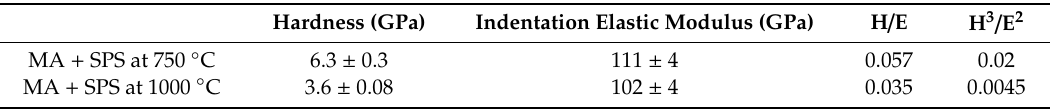
Figure 12. Elastic modulus and hardness curves with the depth for the SPS 750 ◦ C sample, ( a ) Elastic modulus ( b ) Hardness. Table 8. Hardness (H), Elastic modulus (E) and ratios H / E and H 3 / E 2 for consolidated powders at 750 ◦ C and 1000 ◦